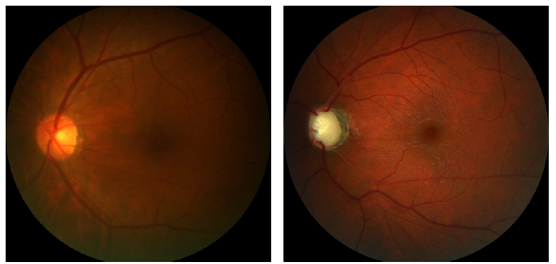
Figure 4. Photos n0002.jpg of the group without glaucoma ( left ) and g0002.jpg of the group with glaucoma ( right ), both reduced to 25% of the original size.